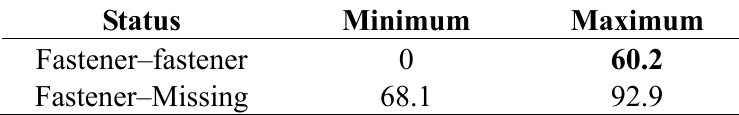
Table 4. Intra and interclass distances for the blur samples.